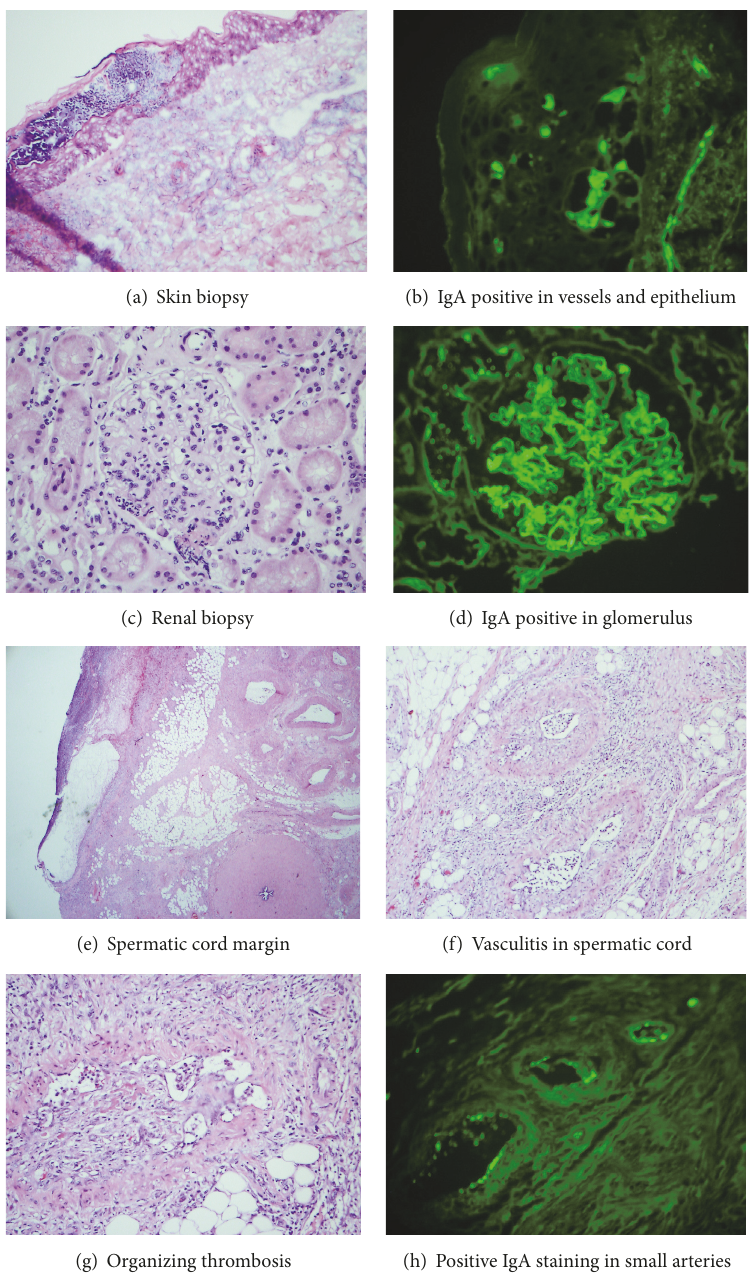
Figure 1: Evaluation of skin biopsy, renal biopsy, and orchiectomy specimens from the 51-year-old man. (a) Hematoxylin and eosin stained section revealed surface ulceration in the skin. (b) IgA immunofluorescence was positive in epidermis and vessels of dermis. (c) Hematoxylin and eosin stained section revealed mesangial expansion with focal neutrophil aggregation in the glomerulus. (d) IgA immunofluorescence was positive mainly in the mesangium and some along the glomerular capillary loops. (magnifications × 400 in (a)–(d)). (e) A low power view ( × 40) revealed the unremarkable vas deferens at the right lower corner and necrosis and abscess in the testicular parenchyma at the left upper corner. (f) Vasculitis was seen in multiple small arteries of spermatic cord at medium power view ( × 200). (g) High power view ( × 400) revealed organizing thrombus in a small artery causing nearly total occlusion of the vessel in the spermatic cord. (h) IgA immunofluorescence ( × 200) was positive (green granular staining) at the endothelium of multiple inflamed small arteries. Hematoxylin and eosin stains were performed in